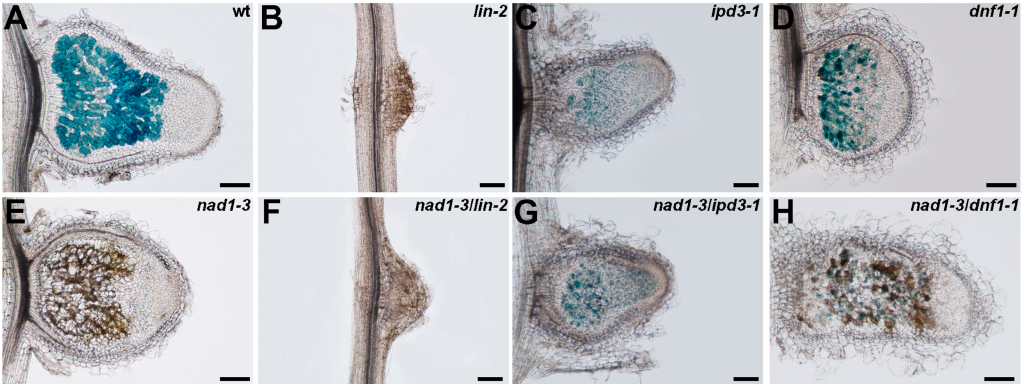
Figure 7. The defense responses are activated in nad1-3 following the internalization of rhizobia but prior to bacteroid differentiation. Nodulation phenotype of wild-type (Jemalong) ( A ), lin-2 ( B ), ipd3-1 ( C ), dnf1-1 ( D ), nad1-3 ( E ), nad1-3/lin-2 ( F ), nad1-3/ipd3-1 ( G ), and nad1-3/dnf1-1 ( H ), mutants 14 dpi